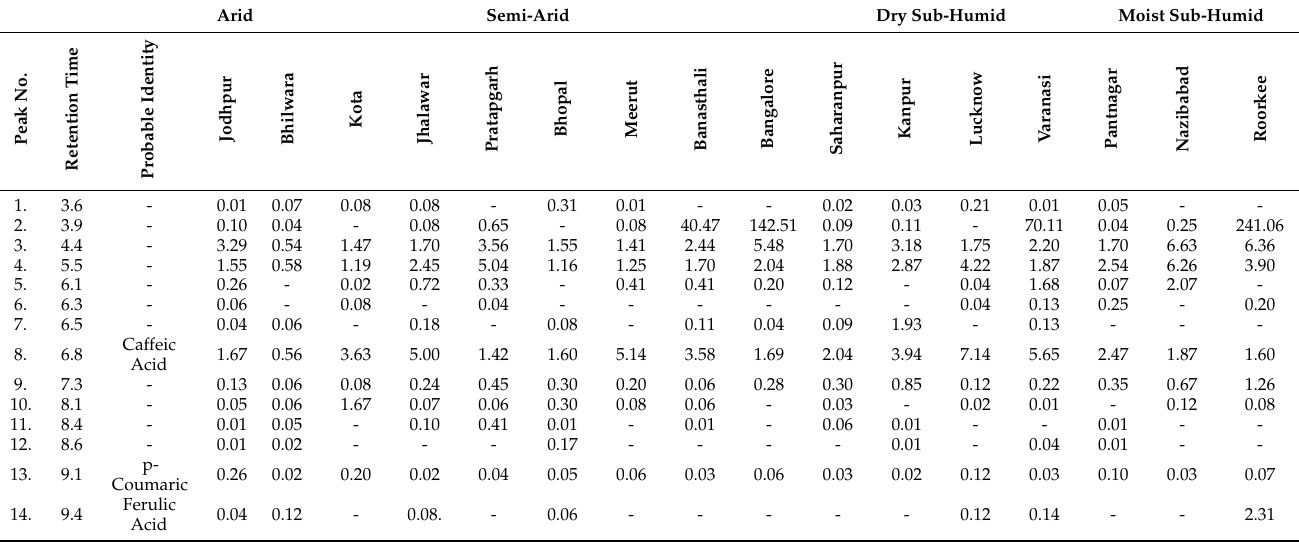
Table 9. Quantification of total phenolics in S. cumini (mg.gdwt –1 )